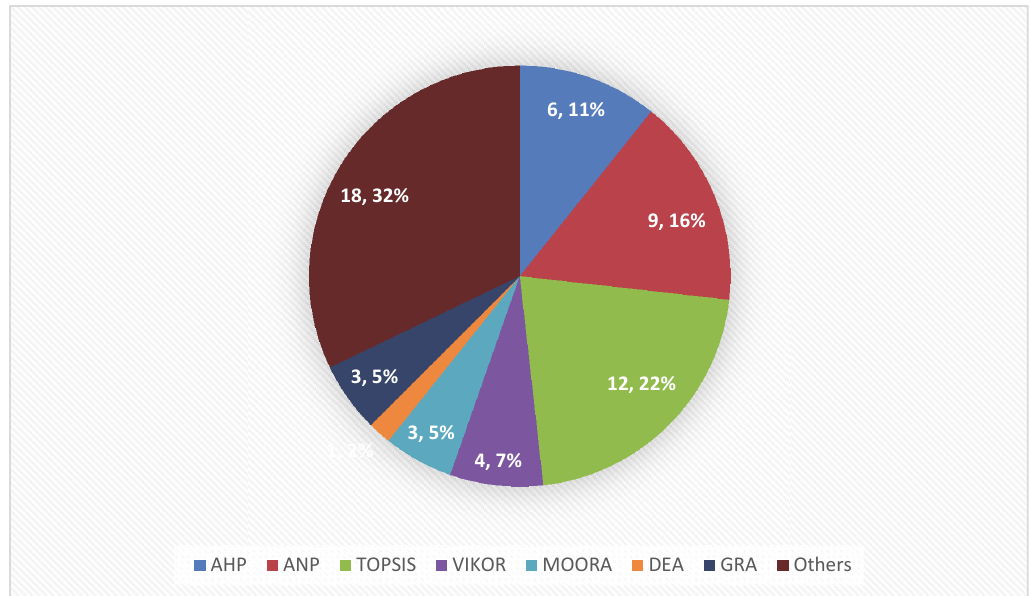
Fig. 2. Distribution of the MCMD applications for project